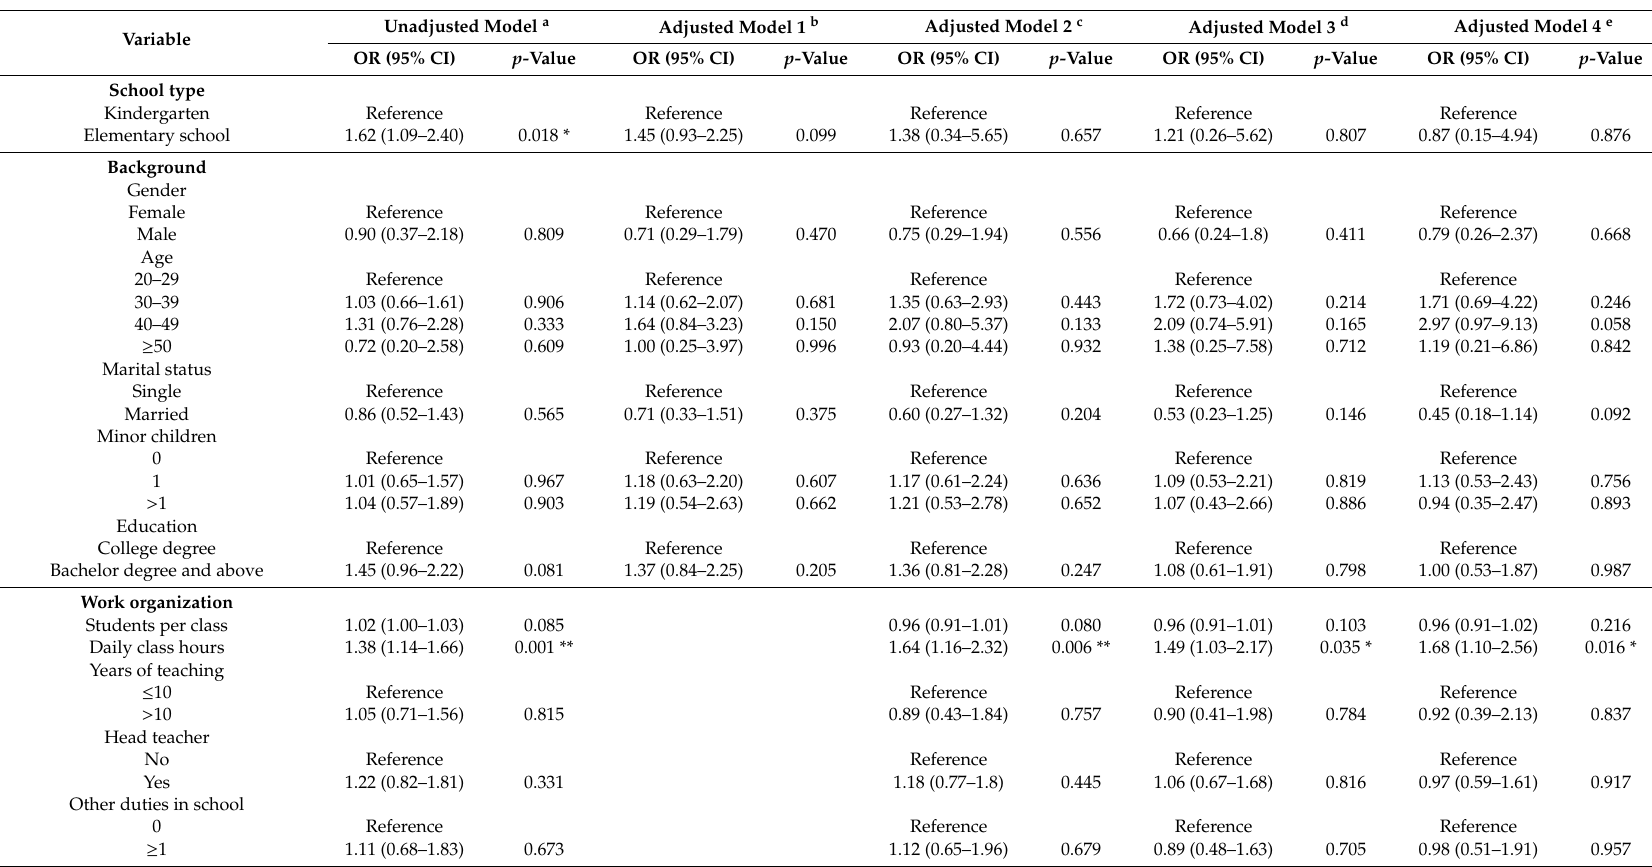
Table 4. Multivariate logistic regression analysis for voice disorders in early childhood teachers, Yancheng City, Jiangsu Province, China (2019), n =